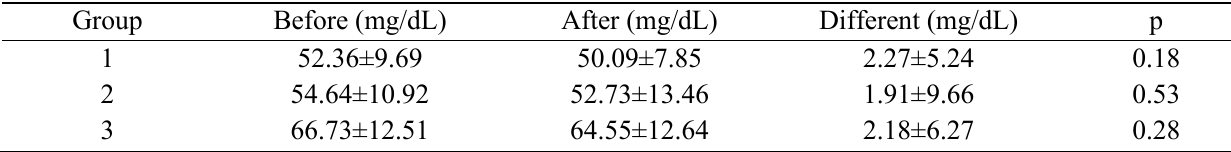
Table 4.Mean of HDL-C levels before and after intervention Group